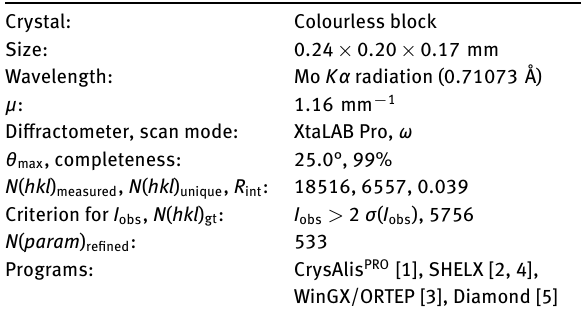
Table 1 contains crystallographic data and Table 2 contains the list of the atoms including atomic coordinates and dis- placement parameters.